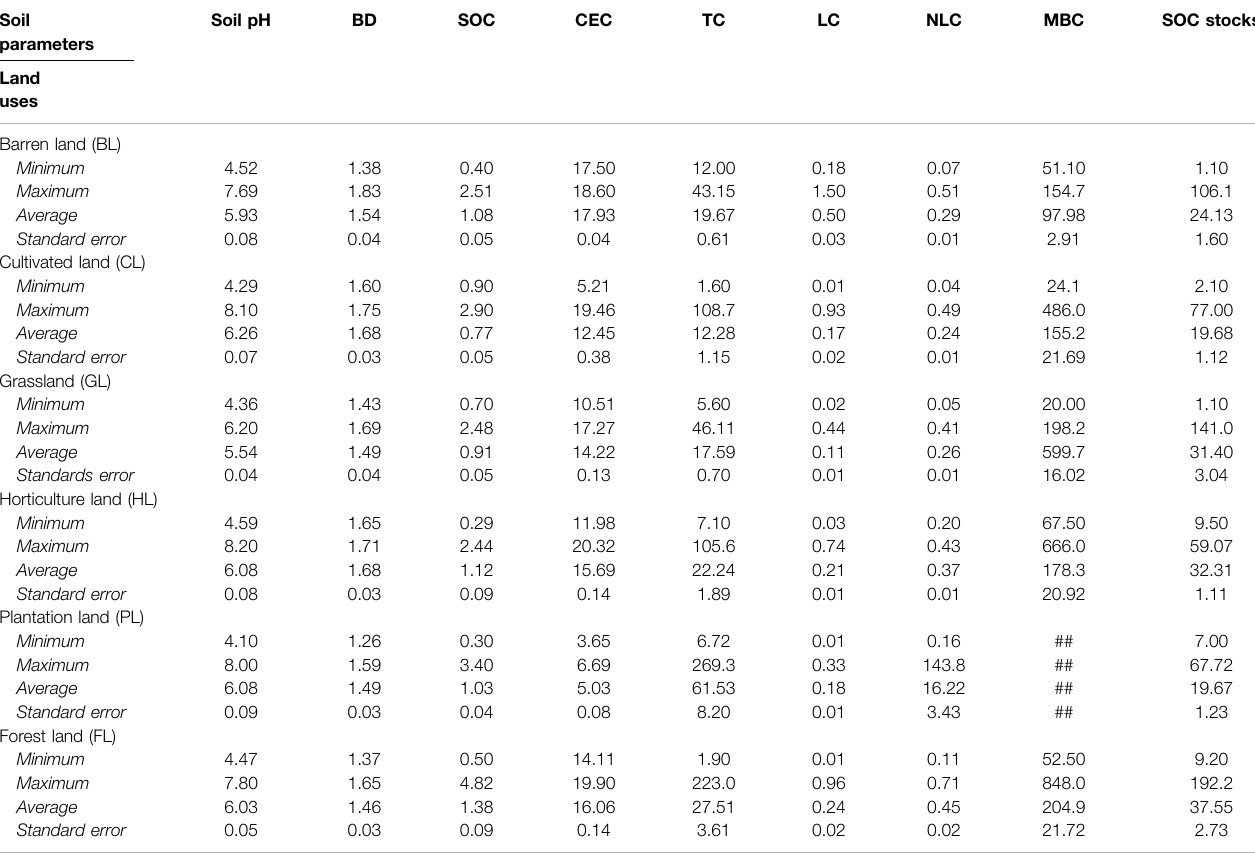
TABLE 3 | Soil characteristics of various land uses from the collected